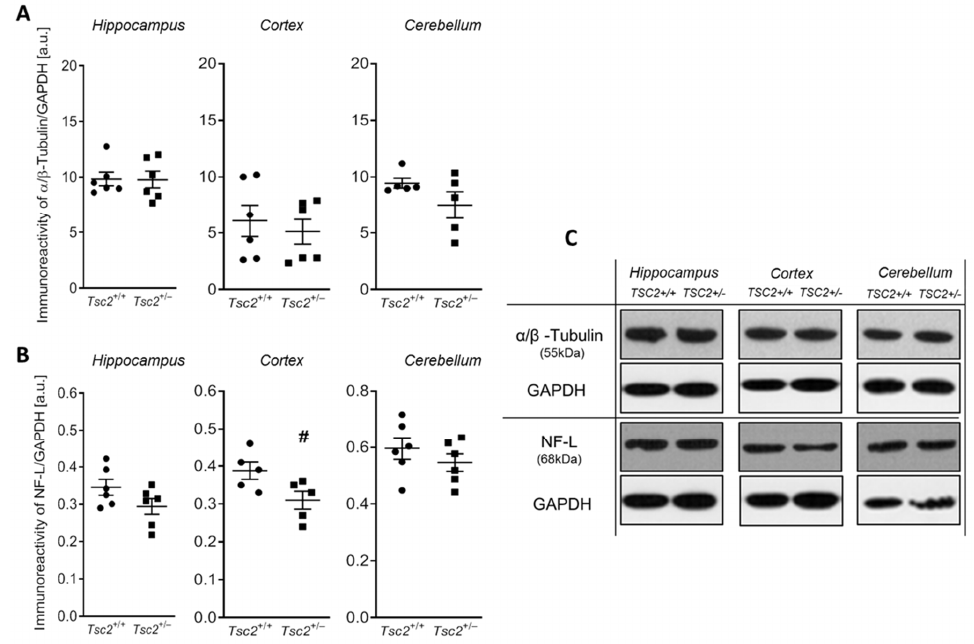
Figure 2. The effect of Tsc2 haploinsufficiency on the protein level of α / β -tubulin and NF-L in the mouse brain. Immunoreactivity of α / β -tubulin and NF-L protein in control and Tsc2 +/ − mice were monitored using Western blot analysis. Densitometric analyses of α / β -tubulin ( A ) and NF-L ( B ) and representative pictures ( C ) are shown. Results were normalized to GAPDH levels. Data represent the mean values ± SEM from n = (5–6) separate animals from three different litters. Data were ana ‐ lysed using Student’s t ‐ test. # p < 0.05, vs. control (wild ‐ type animals).